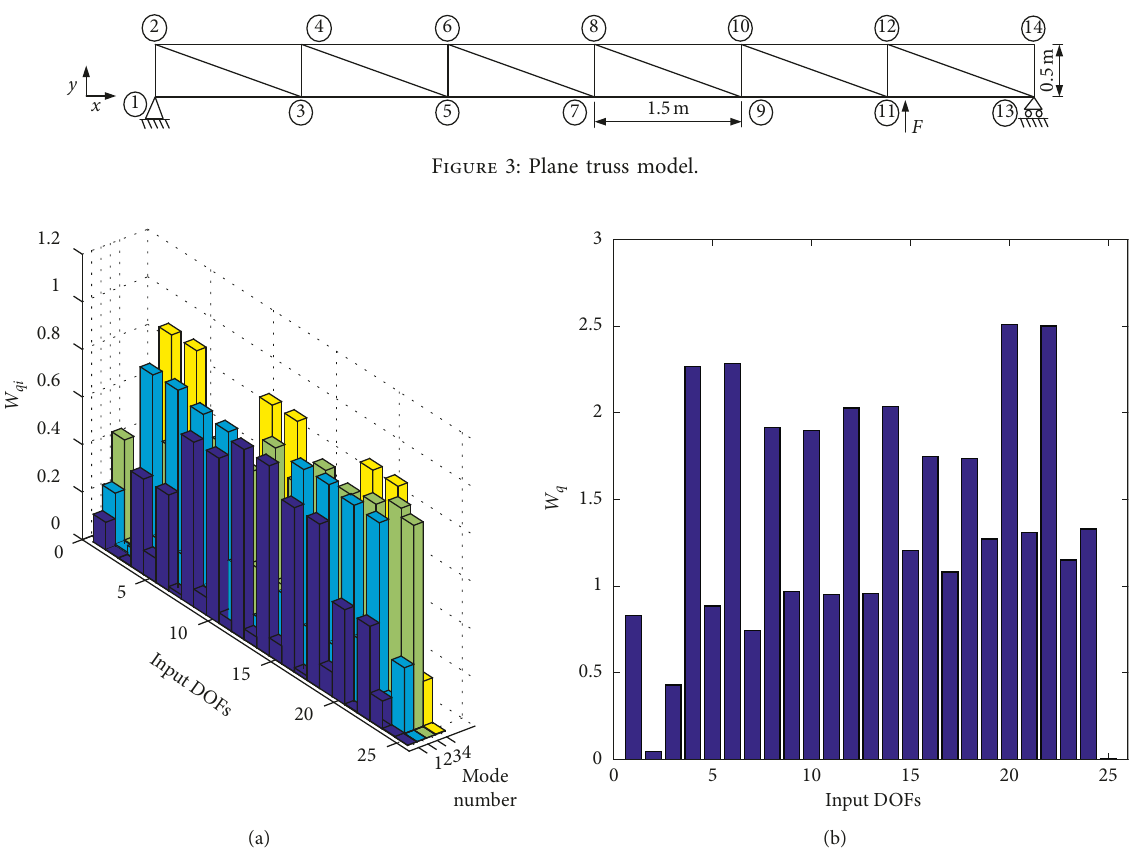
Figure 4: Value of modal participation. (a) W